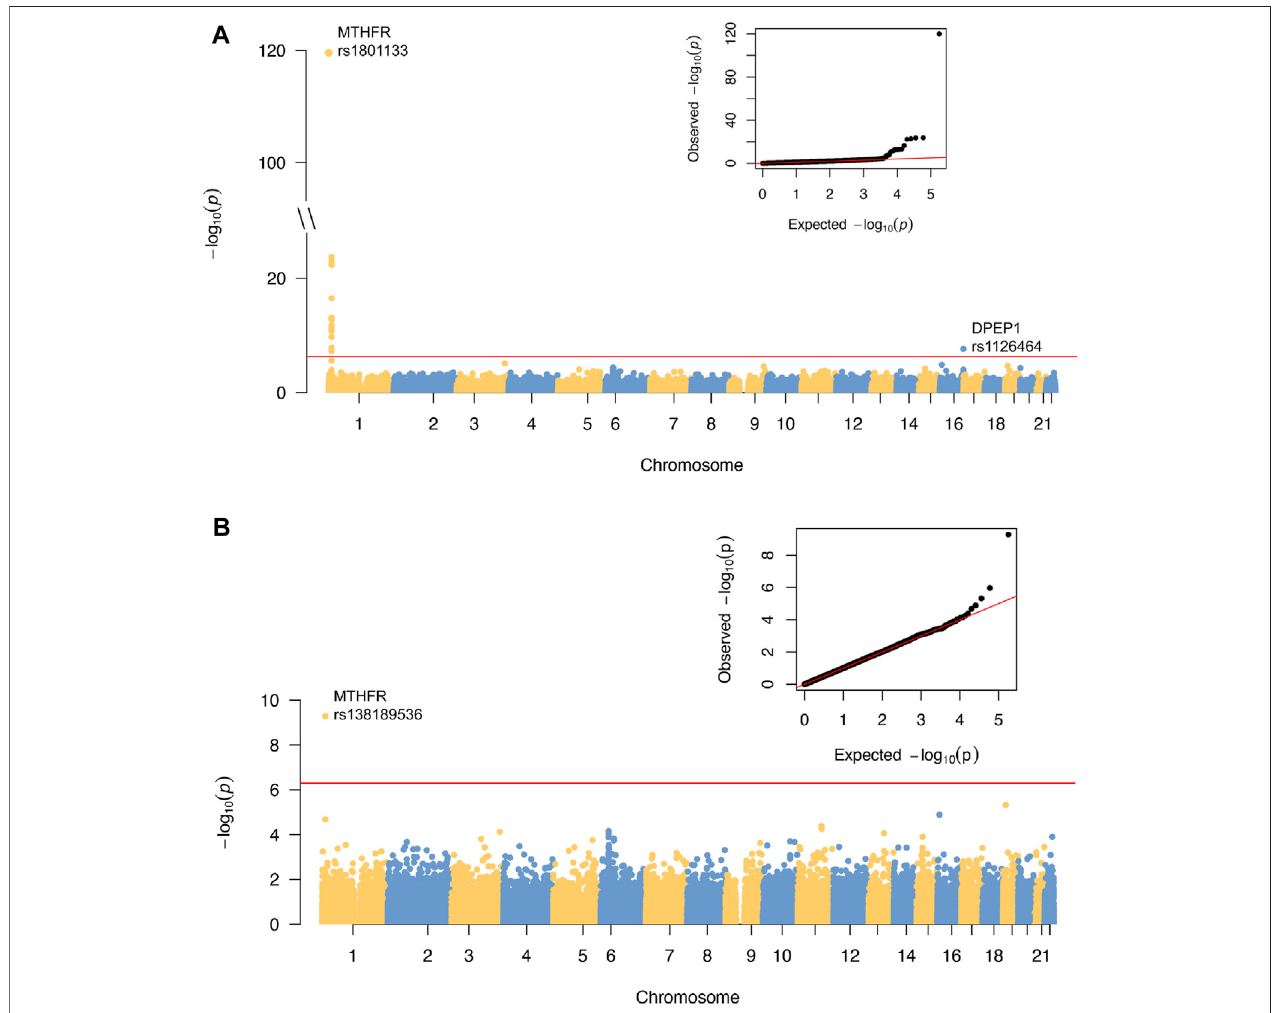
FIGURE1| ResultsofExWASanalysisandconditionalanalysisoftHCYindiscoverycohort. (A) ManhattanplotandQ-QplotoftheExWAS. (B) Manhattanplotand Q-Q plot of the conditional analysis. For Manhattan plots, the horizontal axes are genomic location (GRCh37.p13) of all the tested SNPs. The vertical axes are the negativelogof p -values.Redlinesindicate thethreshold forexome-widesigni fi cance at5E − 7. ExWAS, exome-wide associationstudy; tHCY, totalhomocysteine;SNP, single-nucleotide polymorphism.